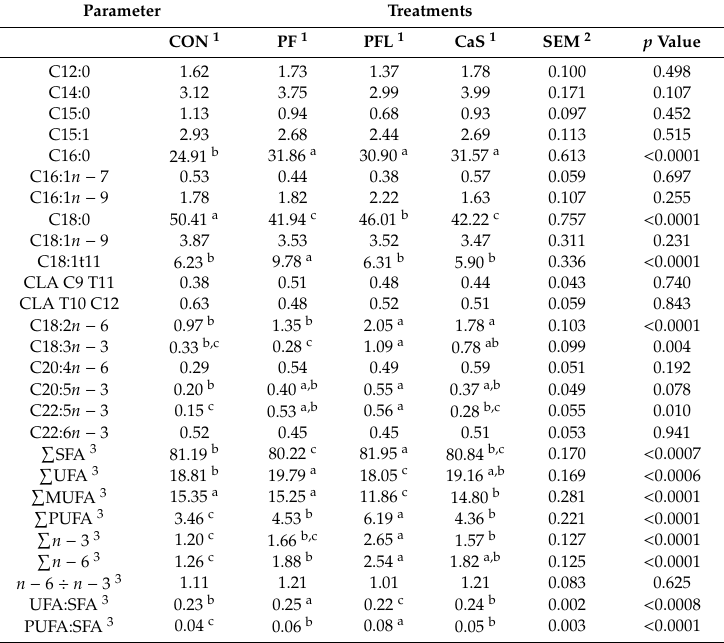
Table 8. E ff ect of di ff erent rumen protected fats on the fatty acid composition of rumen digesta in Dorper sheep. Parameter Treatments CON 1 PF